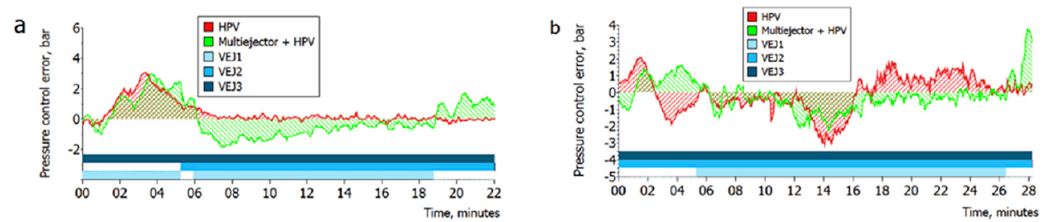
Figure 10. Deviation between the actual value and set-point value for the heat rejection related to a rapid change in load ( a ) and in outdoor temperature ( b ) [15].